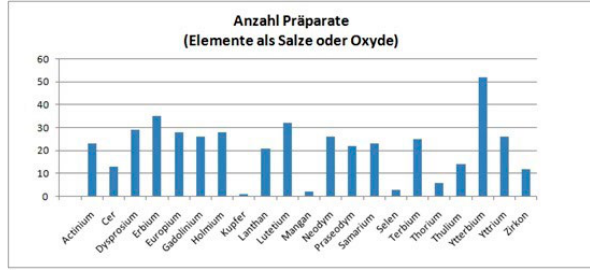
Figure 3. An overview of the compounds of the rare earth metals, which Carl Auer von Welsbach made available to other researchers. Number of compounds (element as a salt or oxide). Source 15 : Gerd Löffler, Carl Auer von Welsbach und sein Beitrag zur frühen Radio- aktivitätsforschung und Quantentheorie , ISBN 978-3-200-04400-5 , 2015 , p.